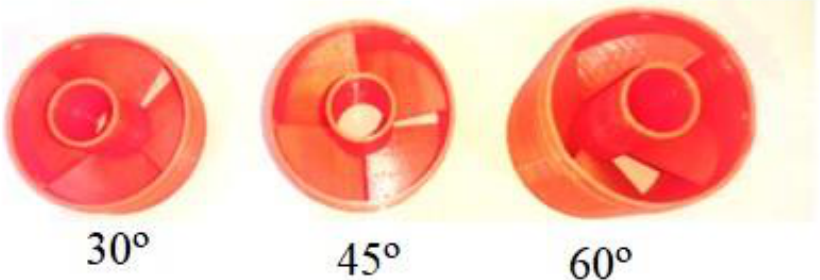
Figure 5. The fan blade angles of the FBHSSR design model.